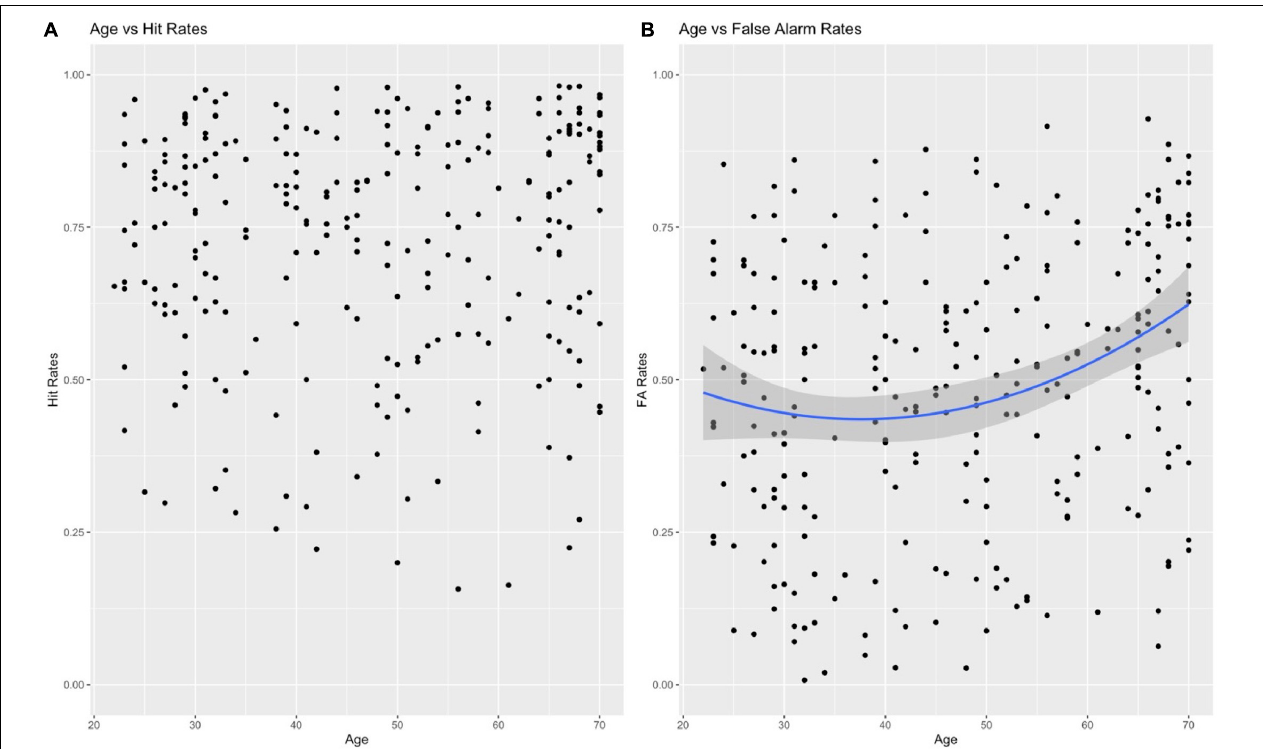
FIGURE 3 | The relationship between age and memory performance – hits and false alarm rates. People at different ages performed similarly in hit rates (A) but older age was significantly related to an accelerated increase in false alarm rate. (B) Shaded area represents 95% confidence intervals for the regression trend line.